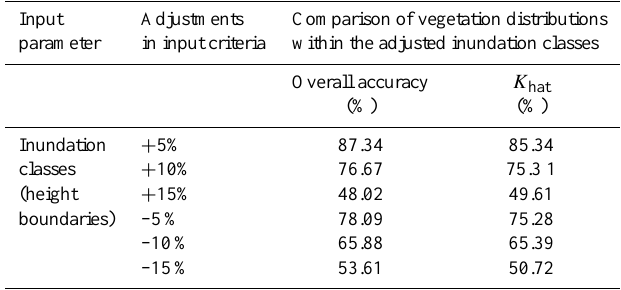
Table B1. Results of the error matrices for map comparison or accu- racy assessment when comparing the vegetation distribution within adjusted height boundaries for the inundation classes. Values repre- sent the overall accuracy and K hat in